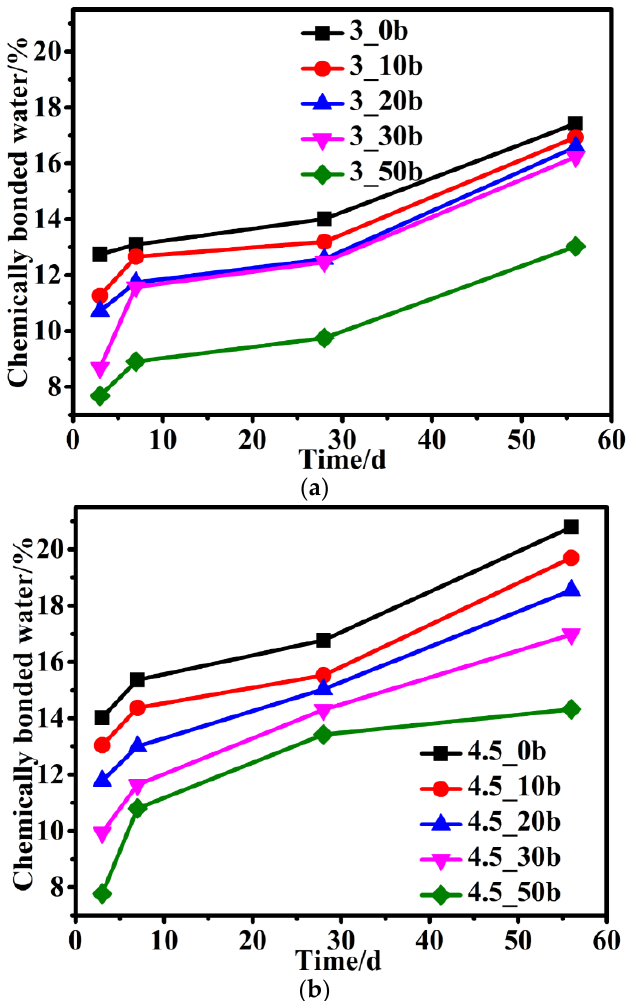
Figure 7. Chemically bonded water of samples at different ages: ( a ) w/b = 0.3, ( b ) w/b =